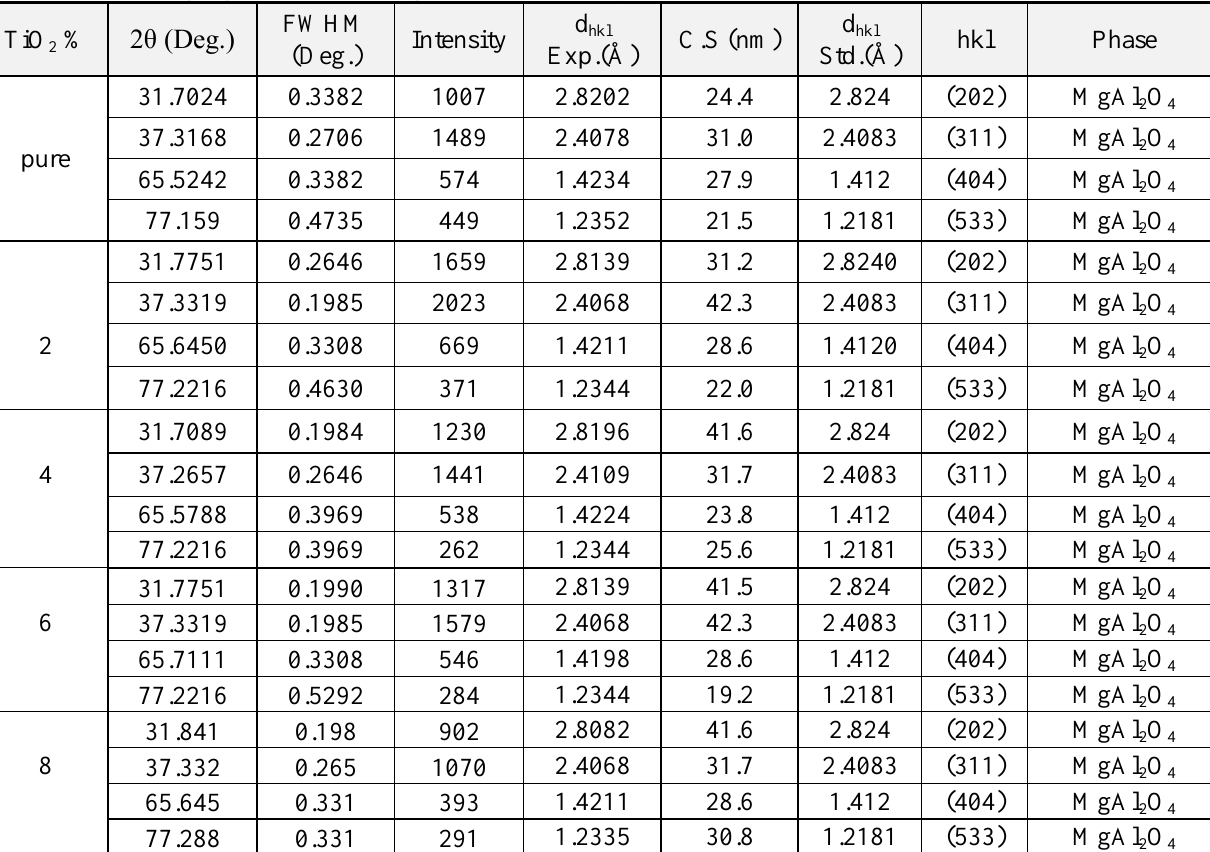
Fig. 2: XRD Patterns of sintered specimens at 1400 ° C with different TiO Table 2: The results (XRD) of the product spinel (MgAl different proportions at a temperature (1400 °